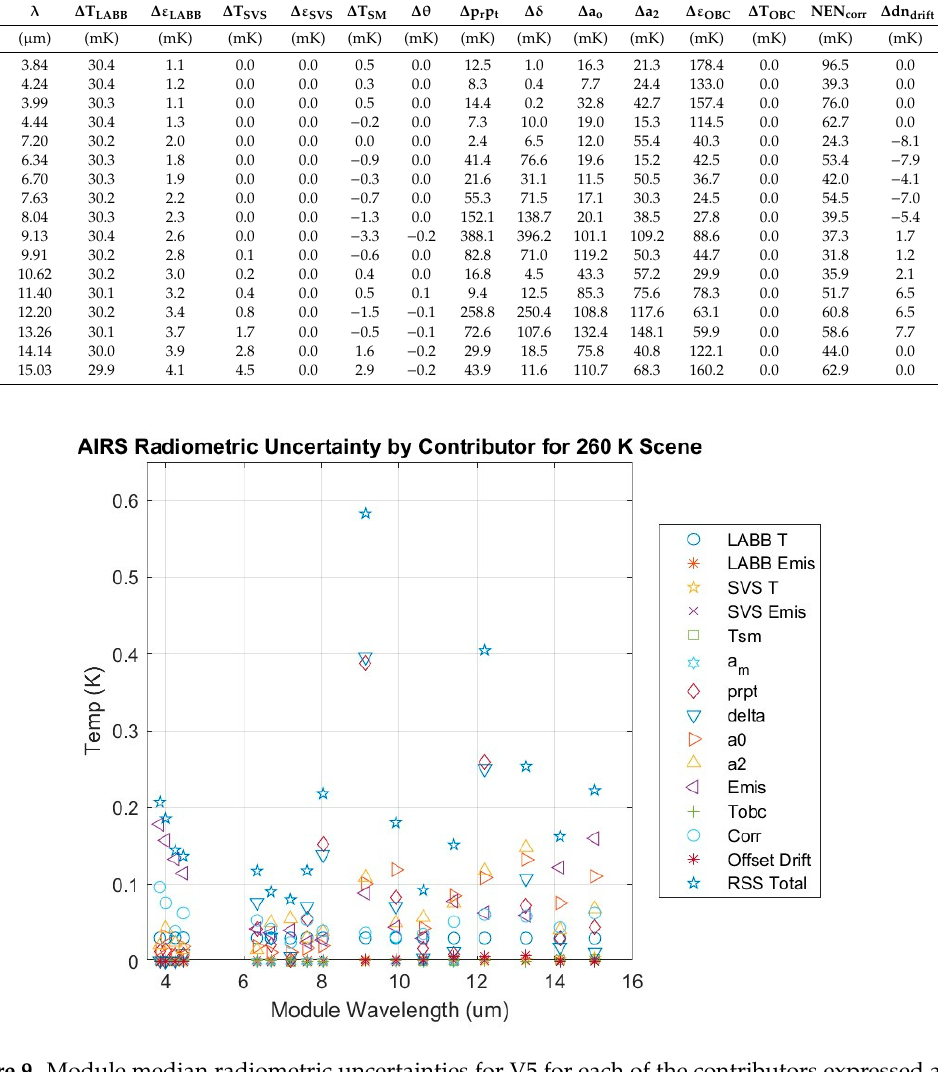
Table 7. Radiometric measurement uncertainty by contributor for the median of all channels in a module. Uncertainties are expressed in terms of a temperature uncertainty for a scene temperature of 260 K. All uncertainties are 1-sigma. Contributors include (according to column order), LABB temperature